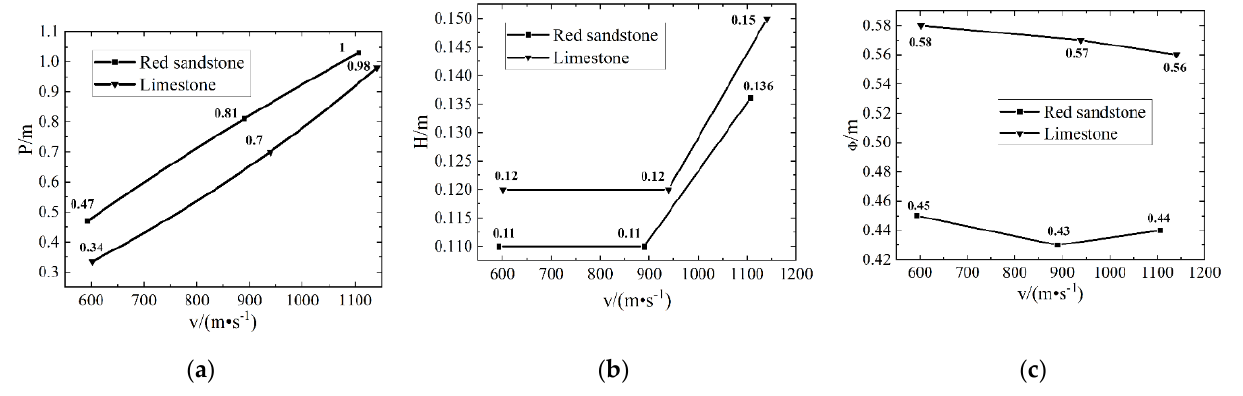
Figure 4. Test results: ( a ) penetration depth; ( b ) crater depth; ( c ) crater diameter.